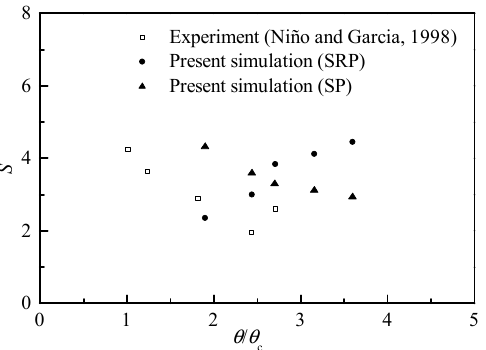
Figure 20. Comparison of angular velocity between the present model results and the experimental data with transport stage [9].